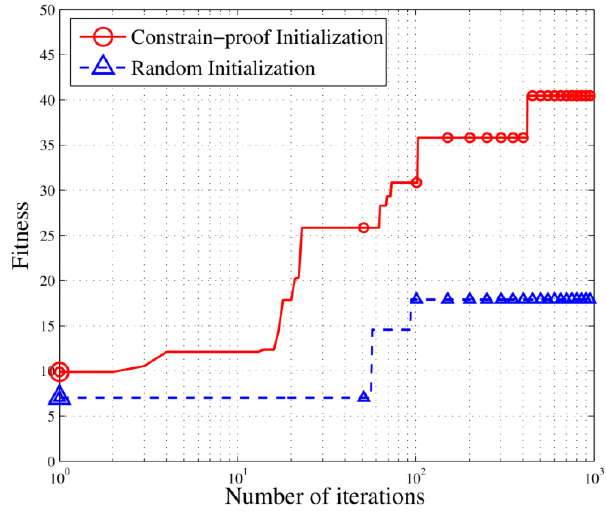
Figure 10. Fitness curves for CI and random initializations